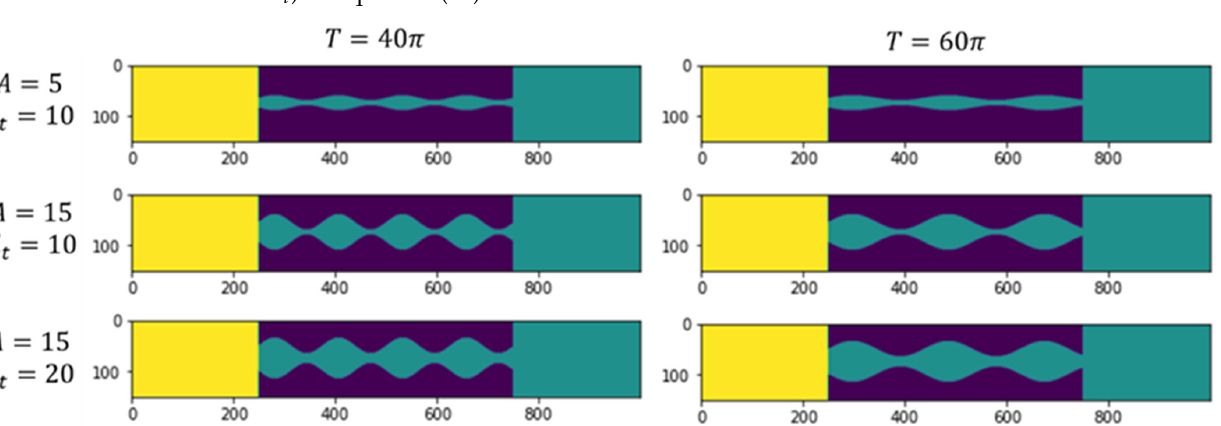
Figure 10. The capillary shapes under different parameters ( A , 𝑇 , and